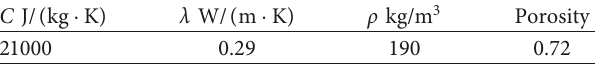
Table 1: Snow cover model variables.